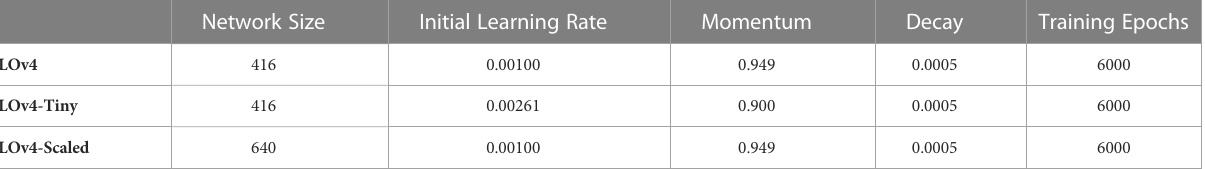
TABLE 3 Summary of the model